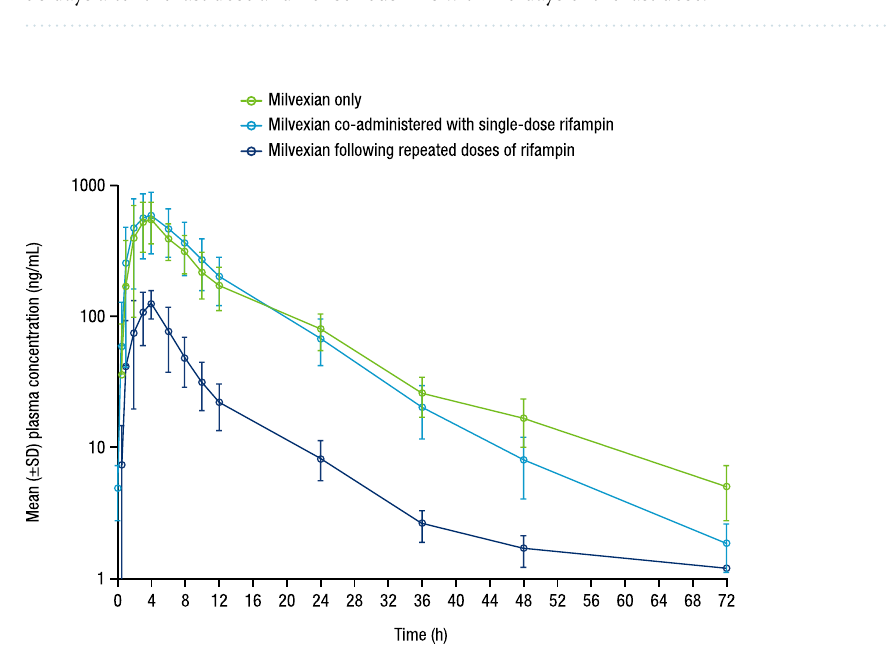
Table 2. Adverse events. AE, adverse event; SAE, serious adverse event. a Includes on-treatment SAEs within 30 days after the last dose and nonserious AEs within 3 days of the last dose.